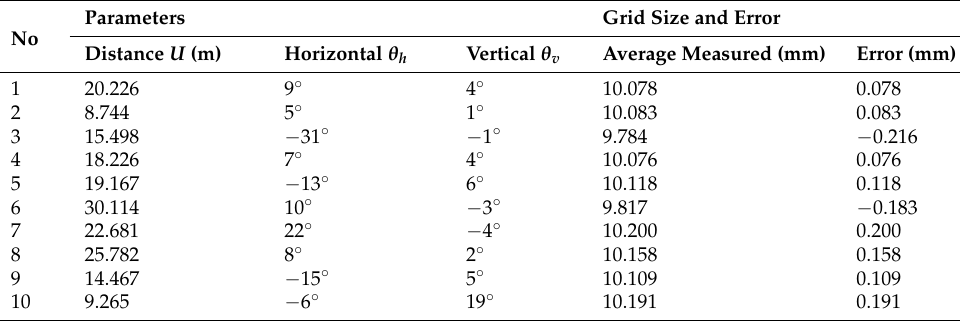
Figure 17. Some grid size measuring scenarios: the distance, horizontal and vertical angle are ( a ) 20.2 m, 9°, 4°; ( b ) 8.7 m, 5°, 1°; ( c ) 15.4 m, −3 1°, −1 °; ( d ) 18.2 m, 7°. Table 3. Measurements on the grid size of the calibration board.